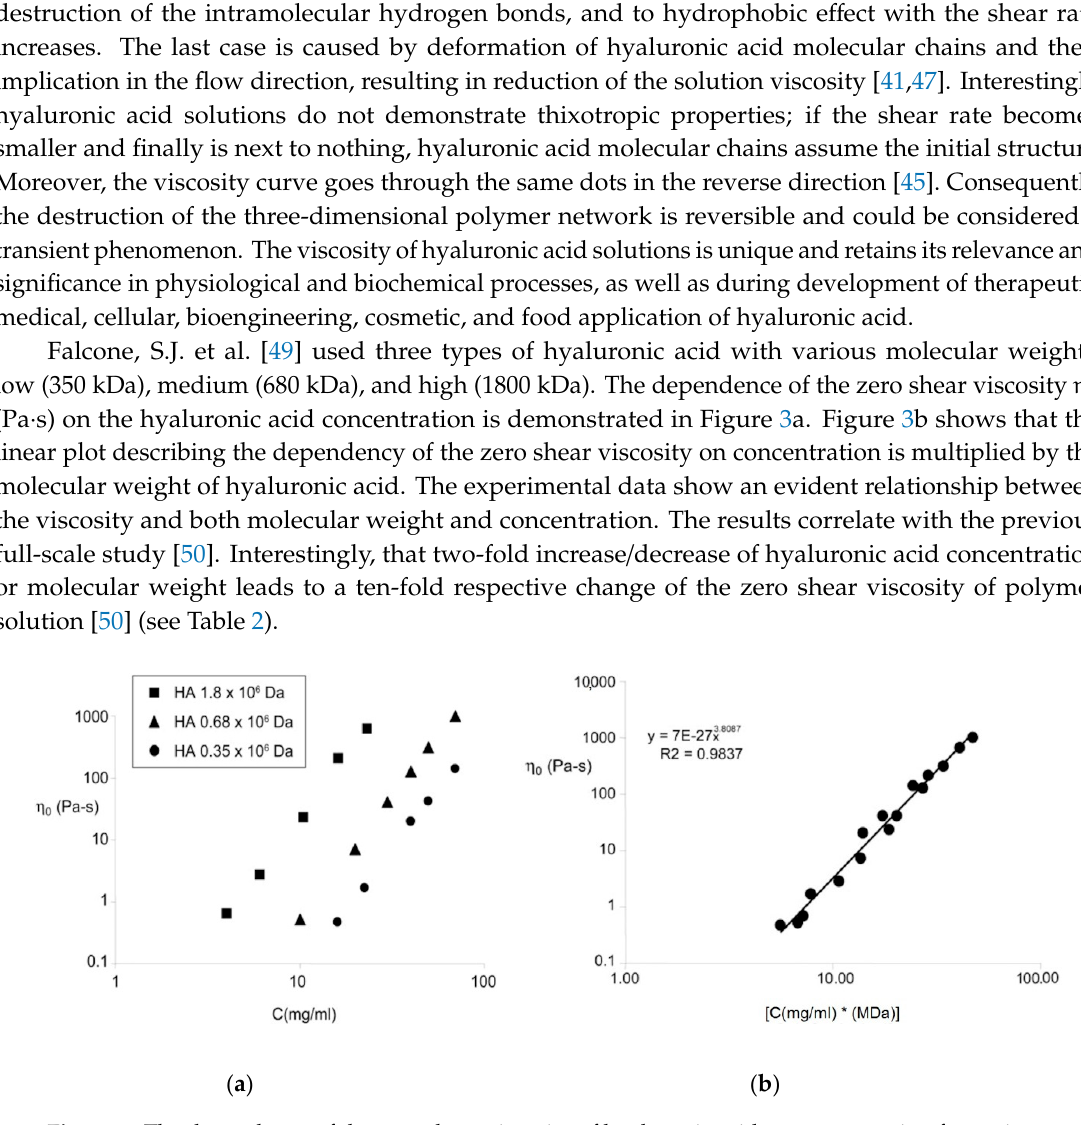
Figure 3. The dependency of the zero shear viscosity of hyaluronic acid on concentration for various molecular weights ( a ); on the [biopolymer concentration × molecular weight] ( b ). Reproduced from [49], with permission from John Wiley and Sons, 2020.